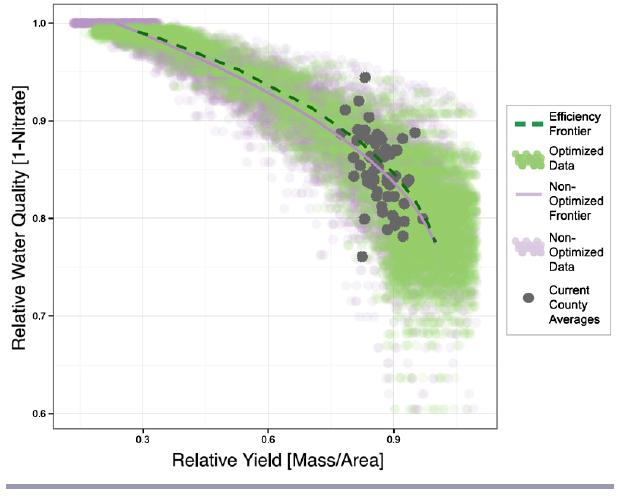
Fig. 2 . Current production of ecosystem services in our study area. Optimized and nonoptimized data are model outputs for each grid cell in the study area; stronger colors indicate a greater concentration of outputs at a given water quality and yield and indicate the range of variation that each dataset presents. Nonoptimized data was subsampled randomly to ensure an equal number of data points between the datasets. Frontiers are the mean of all data in the corresponding sets. Current county averages are estimated based on reported, uniform N application rates for each county in 2001 (Ruddy et al. 2006). Scales are relative to a set maximum (see text).